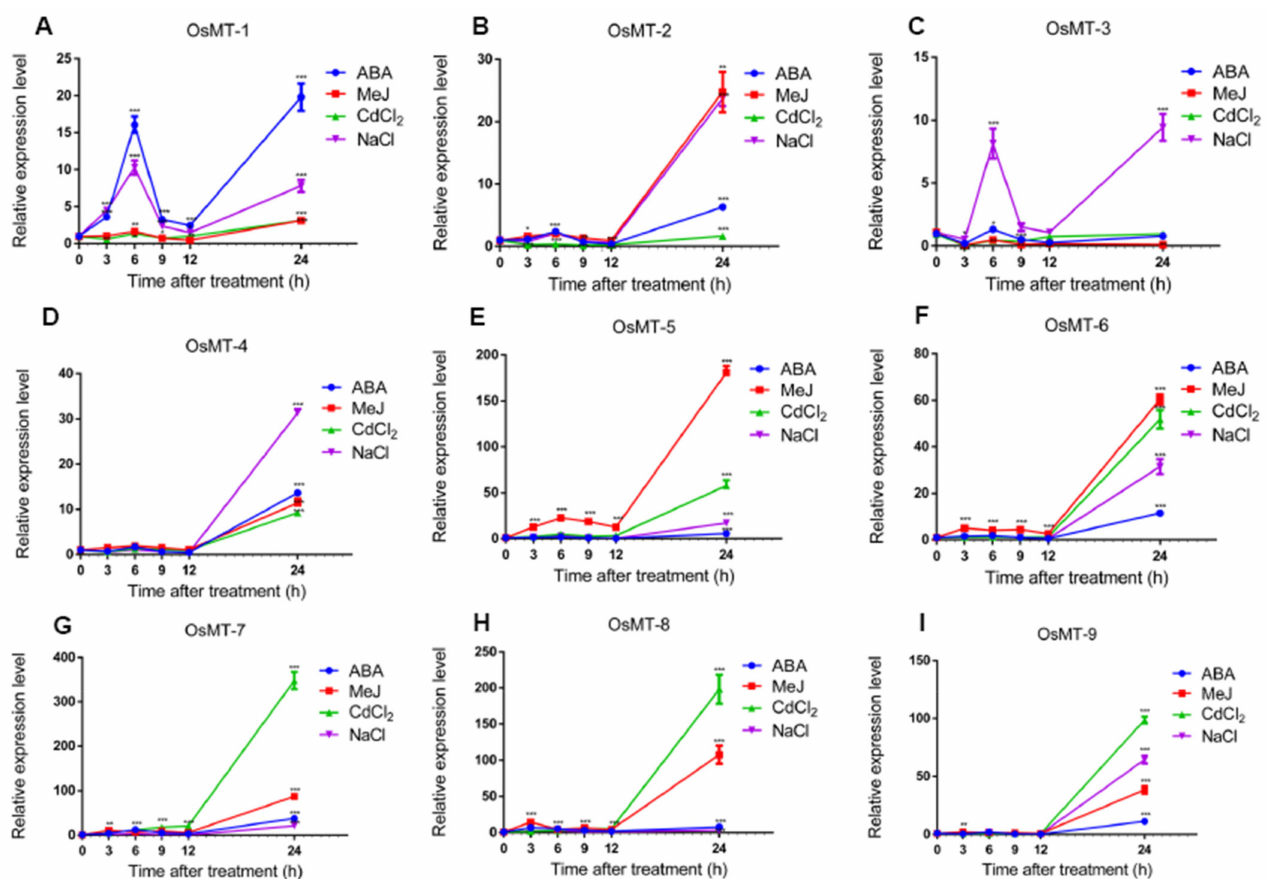
Figure 6. qRT-PCR of relative expression of OsMT genes in roots at the rice seedling stage under various abiotic stress treatments, including NaCl, CdCl 2 , ABA, and MeJ: ( A – I ) the expression of OsMT genes was calculated at 3, 6, 9, 12, and 24 h of treatments compared with the expression value at 0 h, which was normalized to 1. The error bars show the standard deviations of the three independent qRT-PCR biological replicates. Significance analysis was performed using t -test; *: p < 0.05, **: p < 0.01, ***: p <